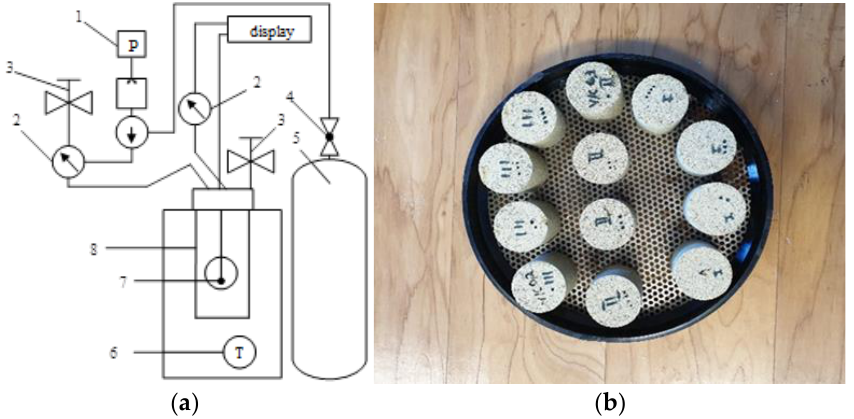
Figure 1. Technological system of samples hardening in CO 2 environment ( a ) and hardened sam- ples ( b ): 1—pneumatic pump; 2—manometers; 3—shutters; 4—ball valve; 5—CO 2 gas cylinder; 6—temperature sensor; 7—autoclave; 8—heater-thermostat.